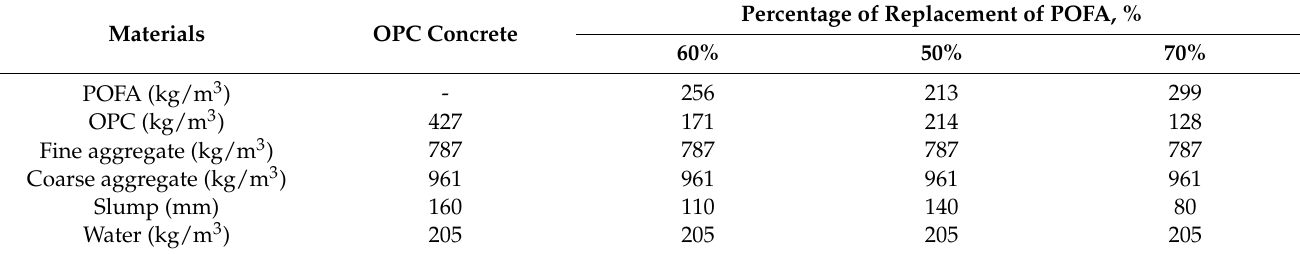
Table 6. Mix characteristics of POFA and OPC concrete [54].